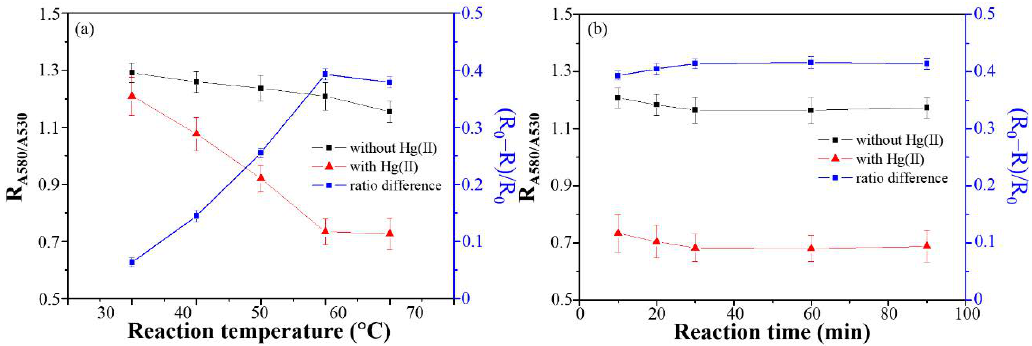
Figure 7. Absorbance ratios (R: A 580 /A 530 ) and catalytic effects ( ■ ) for the H-AuNS probe without ( ■ ) and with ( ▲ ) of Hg(II) (1.0 µM) in the presence of HCl/Au(III)/H 2 O 2 solution, at different ( a ) reaction temperatures and ( b ) times. Error bars represent standard deviations from three repeated experiments.